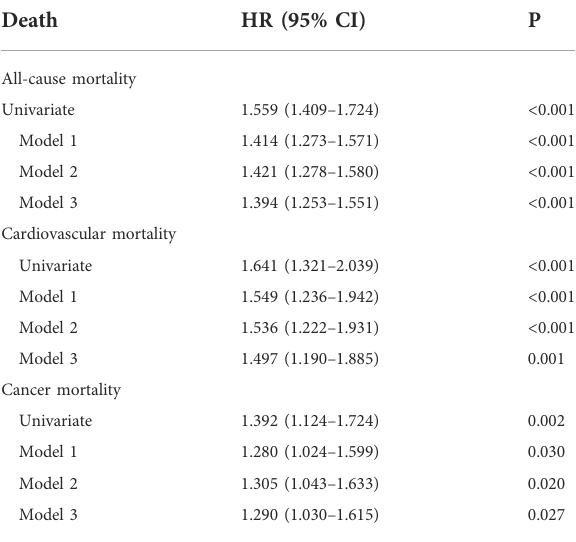
TABLE 3 The hazard risk of hs-CRP ( ≥ 0.5 mg/dl) for mortality in patients with MAFLD.